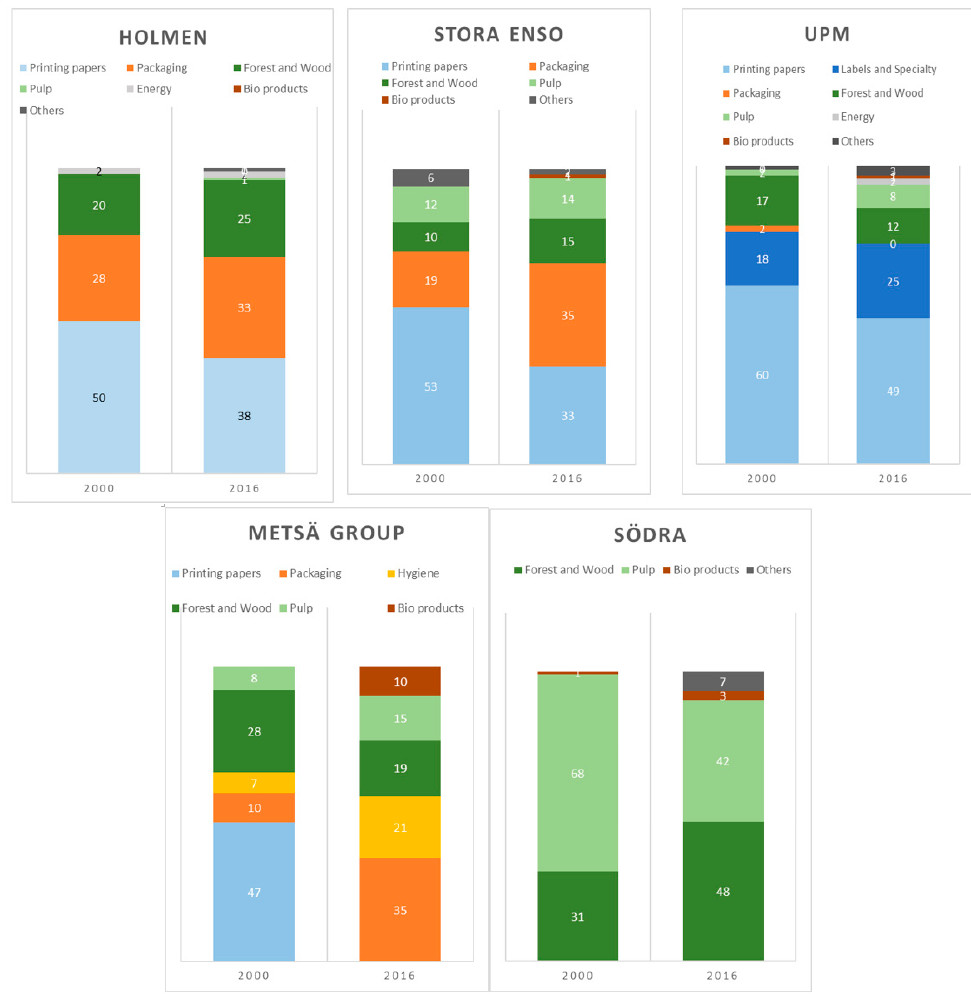
Figure 6. Product portfolios of the generalists. Source: [42,44,48–50].